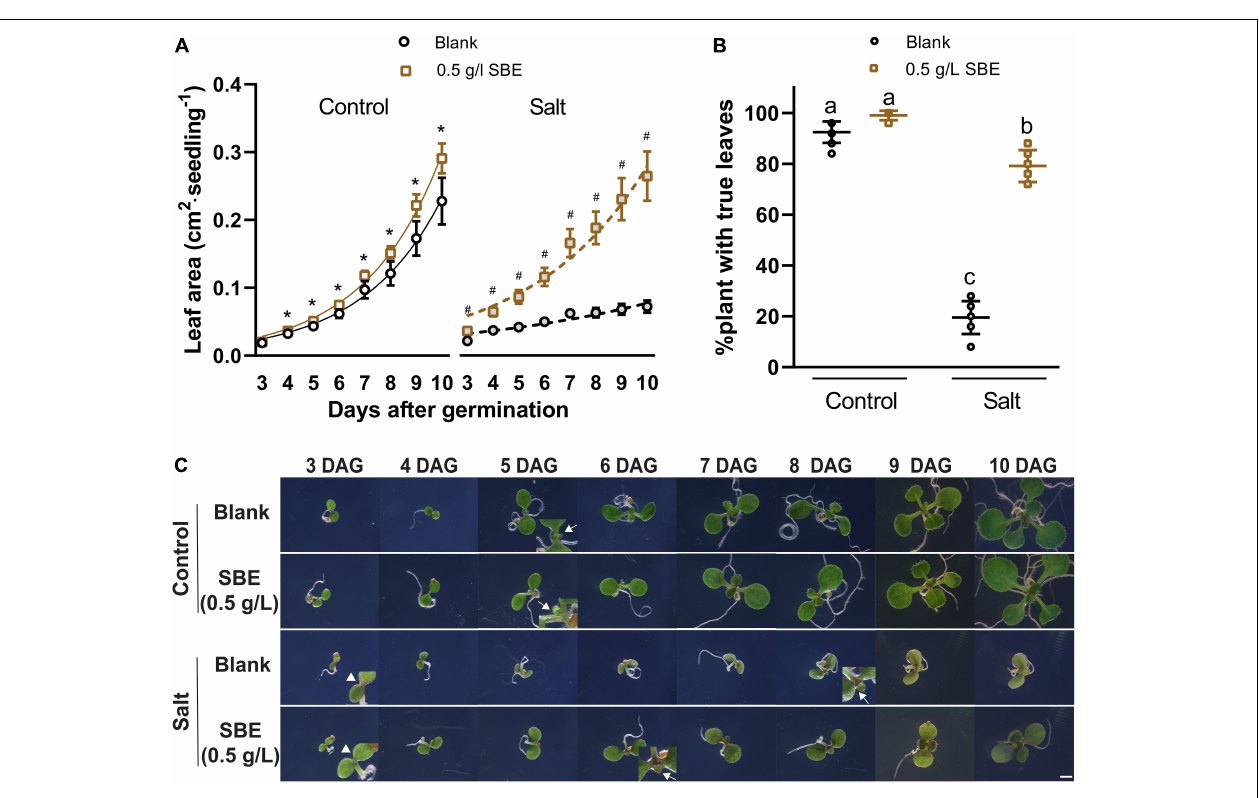
FIGURE 4 | Salt stress alleviation of SBE treatment in the Arabidopsis true leaf assay. (A) The dynamic growth of leaf area from 3 DAG to 10 DAG. Error bars indicate SDs of the means ( n = 9). Different letters represent significant differences between treatments using Tukey’s HSD test ( p < 0.05). Fitted lines were exponential curves of dynamic leaf area growth. The symbols * and # represent significant differences between treatment with or without SBE addition under control or salt stress conditions at the same time point, respectively ( p < 0.05). Both salt treatments were significantly different from the two non-stress treatments at every time point (label not shown). (B) The percentages of plants successfully developed with true leaves at 10 DAG. (C) Phenotype changes of representative seedlings from 3 DAG to 10 DAG focusing on the center of two cotyledons under binocular 6.3 × zoom. Bar = 2 mm. Arrows without tails indicate salt stress alleviation by SBE addition on anthocyanin accumulation at the cotyledon edges of 3 DAG seedlings. Arrows with tails showed the earliest starting time point of visible true leaves. SBE, sunflower bark extract; DAG, days after